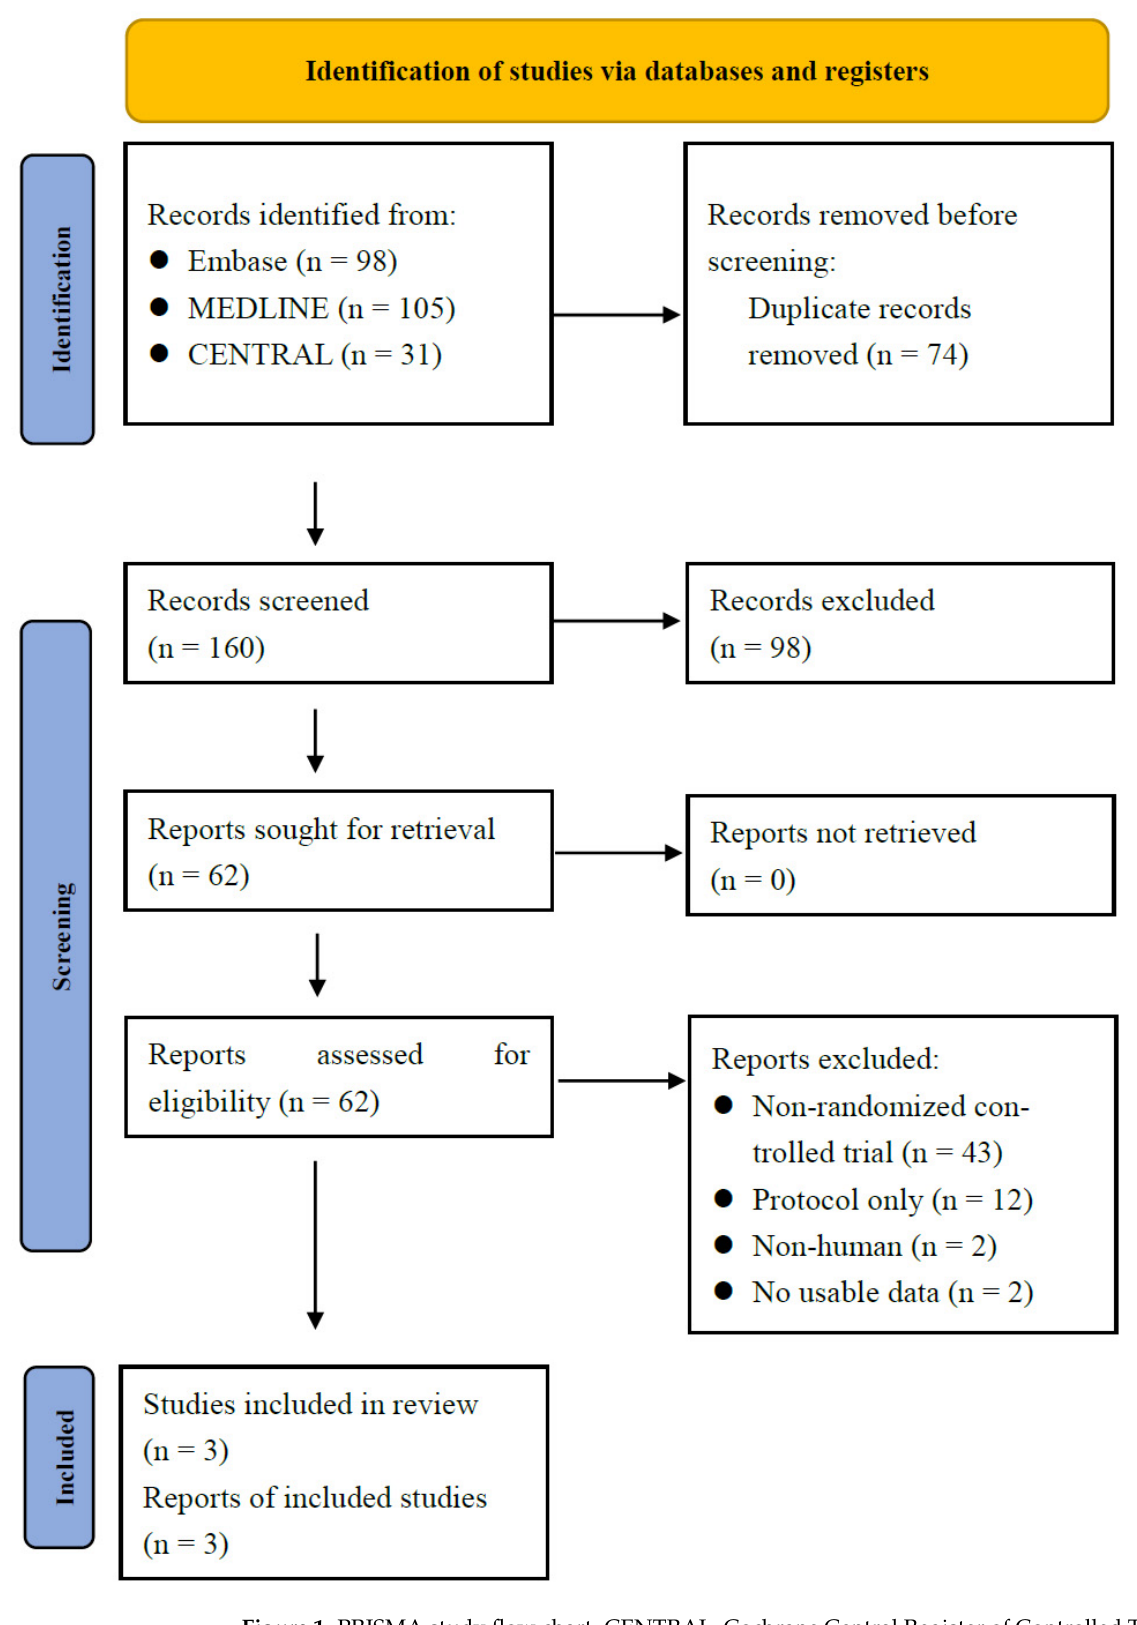
Figure 1. PRISMA study flow chart. CENTRAL, Cochrane Central Register of Controlled Trials.